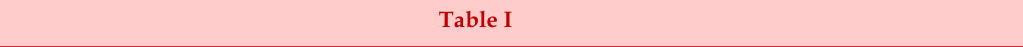
Antifungal activities of ethyl acetate extracts of endophytic fungi from Erigeron canadensis Strain